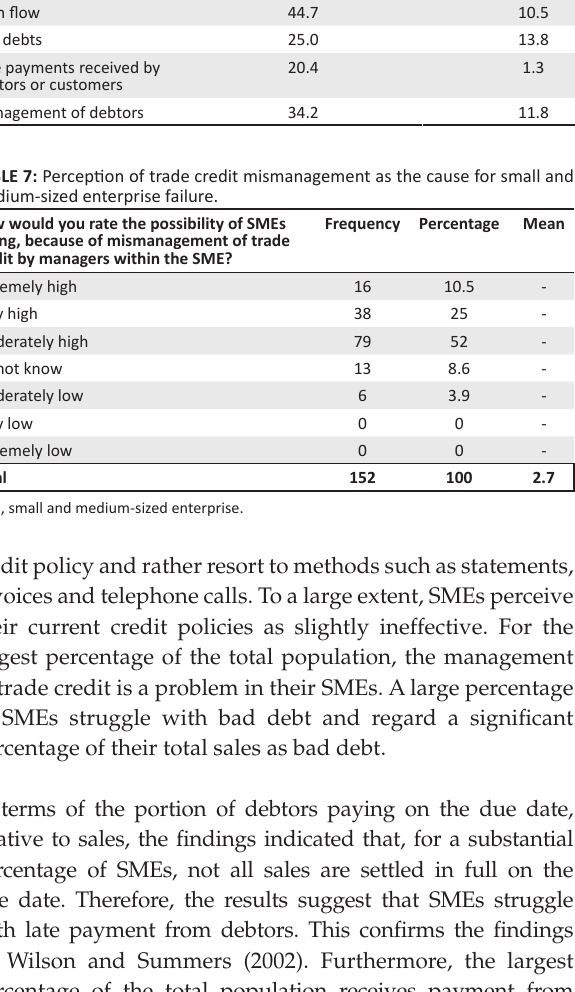
TABLE 6: Main problems encountered with managing trade credit. Factor